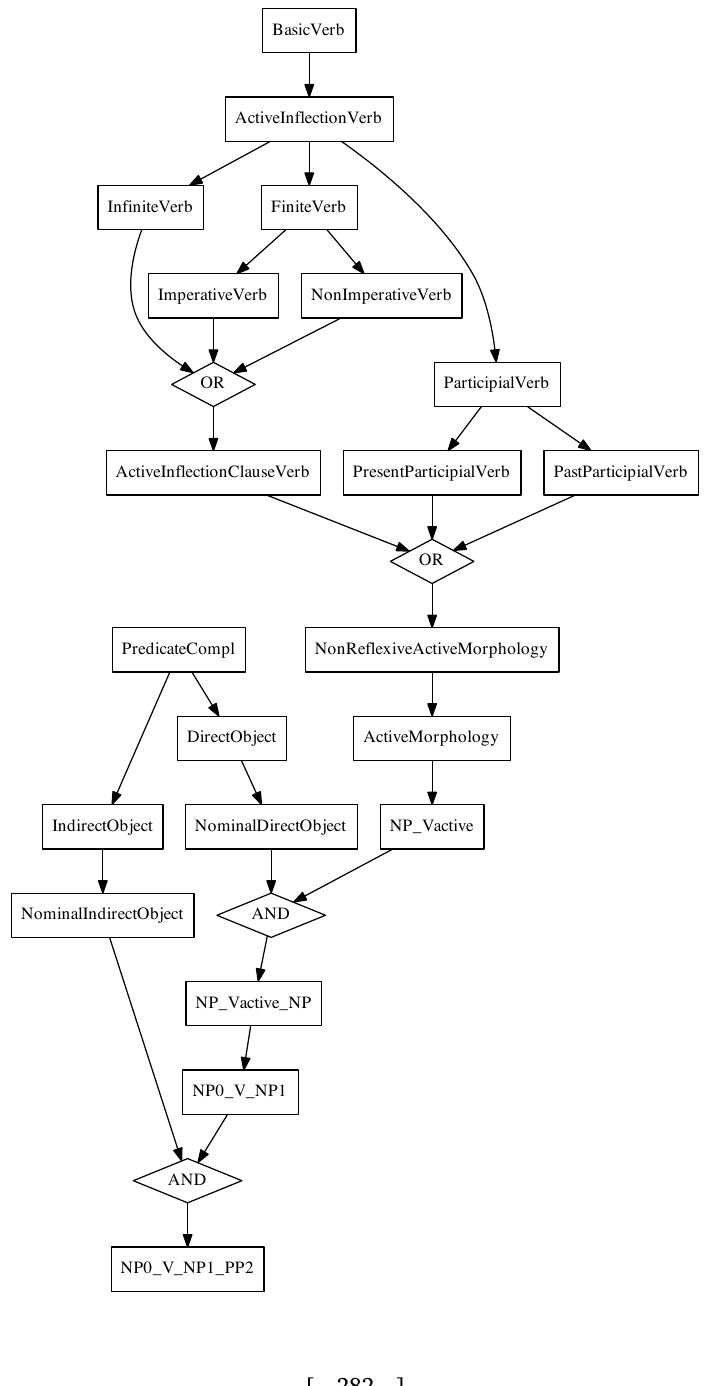
Figure 9: Hierarchy of classes used to define the NP0_V_NP1_PP2 class of transitive verbs with an indirect complement